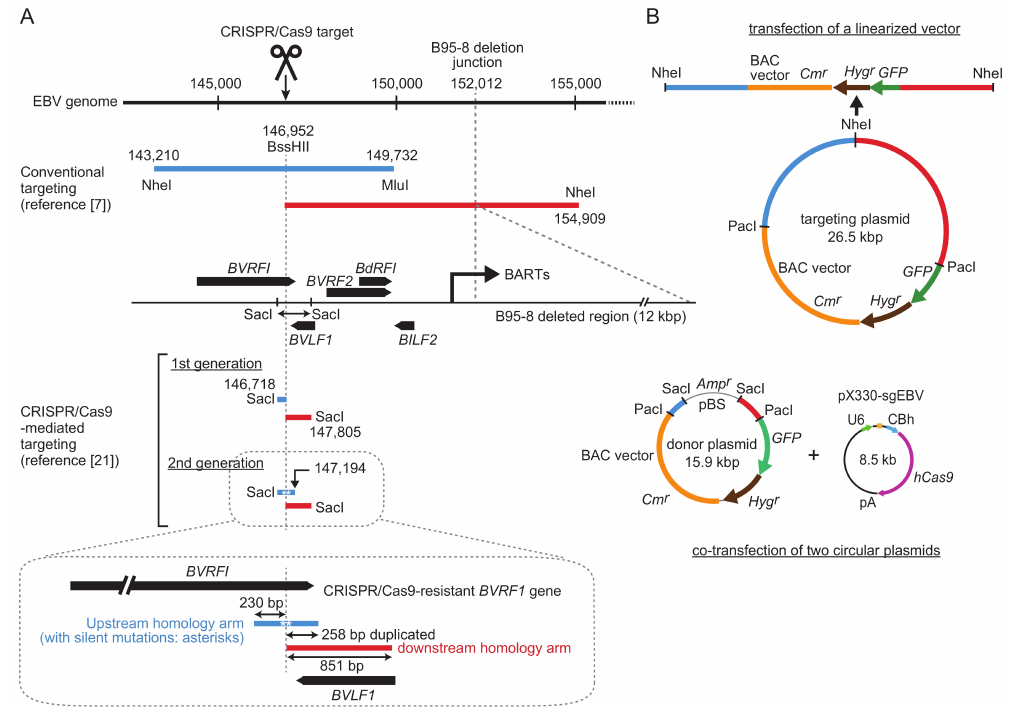
Figure 2. Comparison of homology arm lengths used for conventional and CRISPR/Cas9-mediated EBV-BAC cloning. ( A ) Homology arms employed by conventional targeting [24] and CRISPR/Cas9-mediated targeting [21] are illustrated by preserving their relative sizes. Upstream homology arms are in blue, and downstream homology arms are in red. Nucleotide numbers correspond to those of the B95-8 strain of EBV (V01555.2). EBV ORFs around the transgene insertion site are indicated as black arrows. Restriction enzyme sites used for targeting vector construction are indicated. Upstream and downstream homology arms of the second generation donor plasmid, together with the locations of BVRF1 / BVLF1 ORFs, are illustrated in detail at the bottom. ( B ) Schematic representation of a targeting plasmid (top, for conventional targeting) or a donor plasmid (bottom, for CRISPR/Cas9-mediated targeting). Note their different